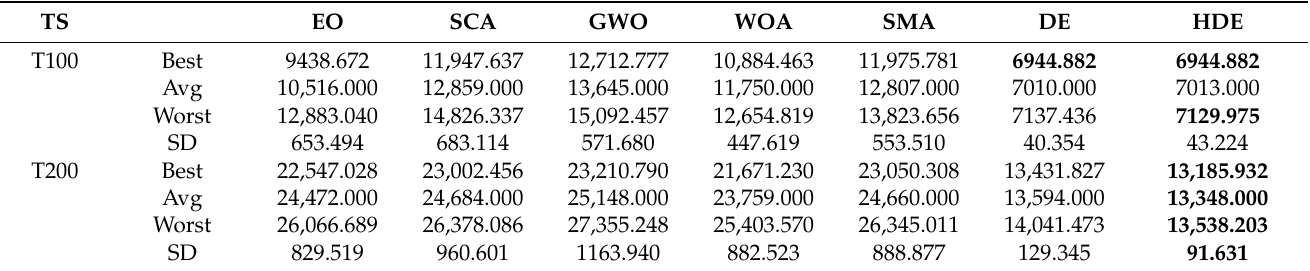
Table A2. Comparison among algorithms for the makespan